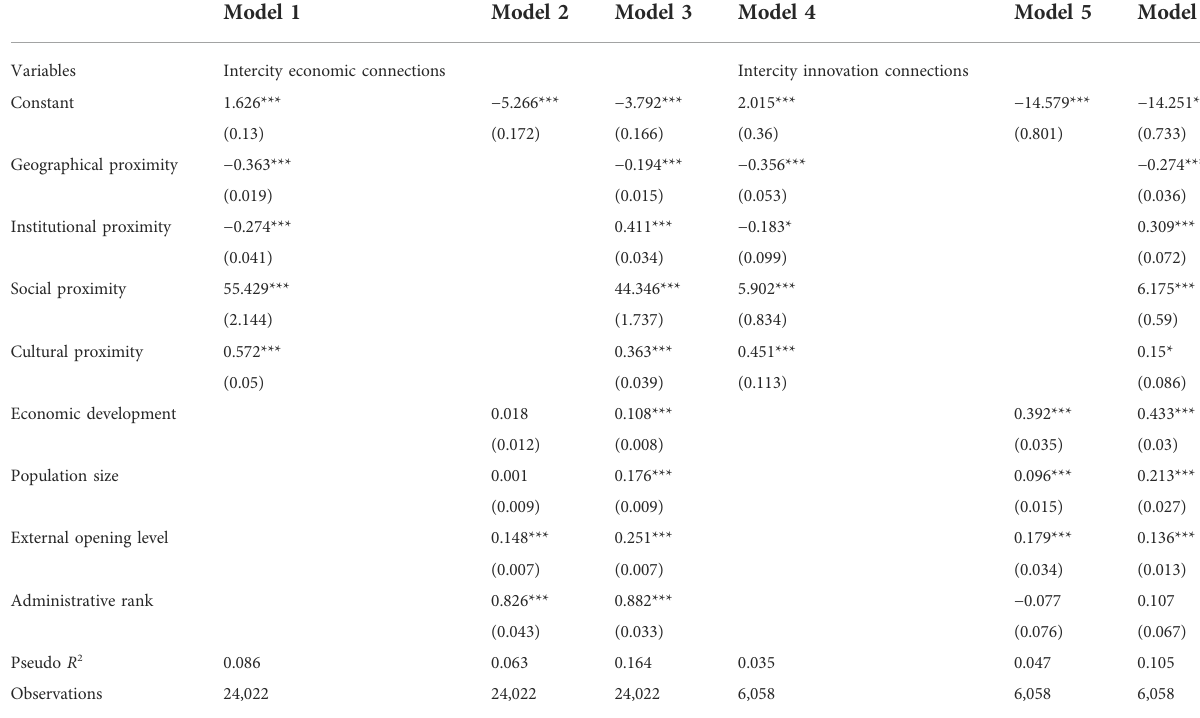
TABLE 2 Regression results of urban network in fl uencer